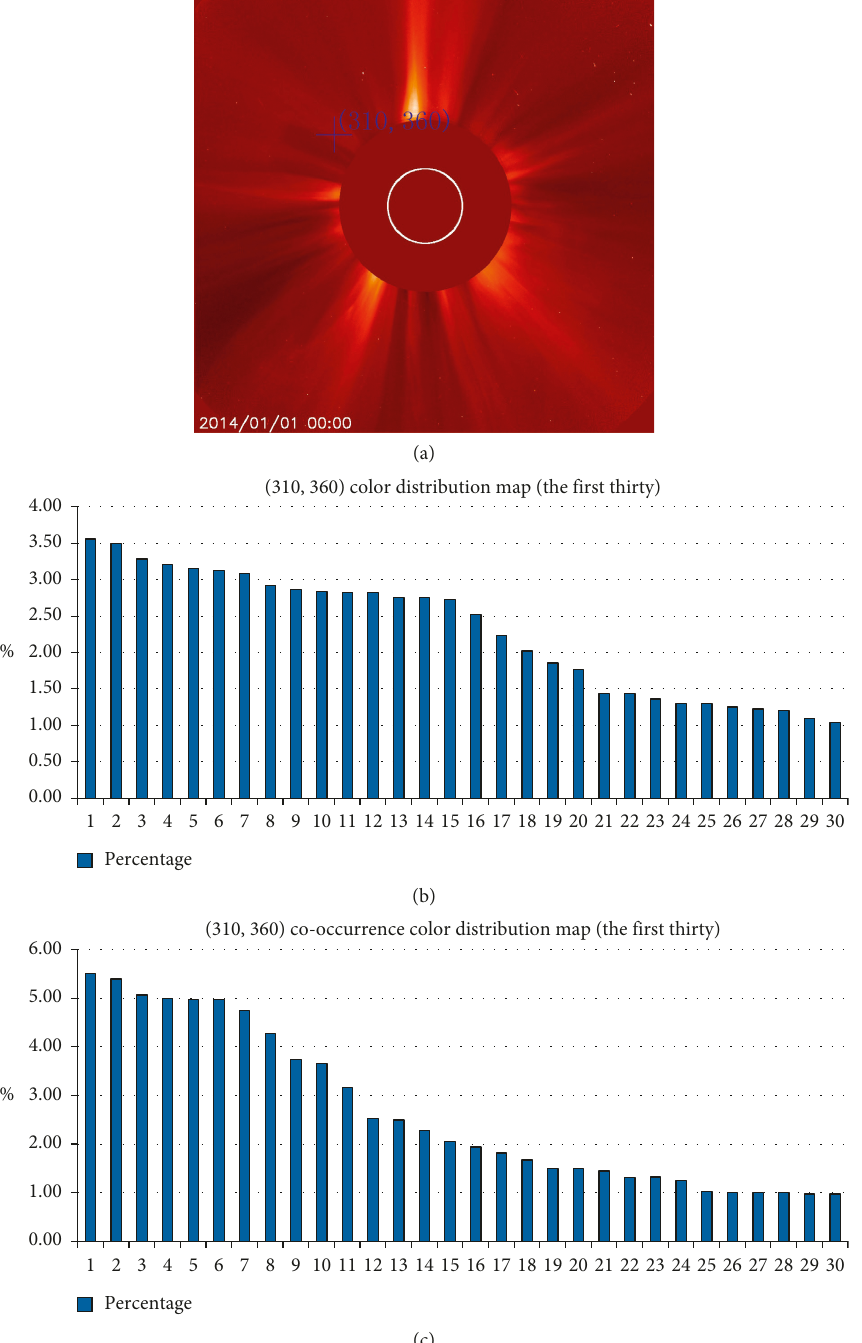
Figure 1: One example of learned principal features of LASCO C2 pseudocolor coronagraph images in the year of 2014. (a) The position of the selected pixel, (b) significant color histogram, and (c) significant co-occurrence color